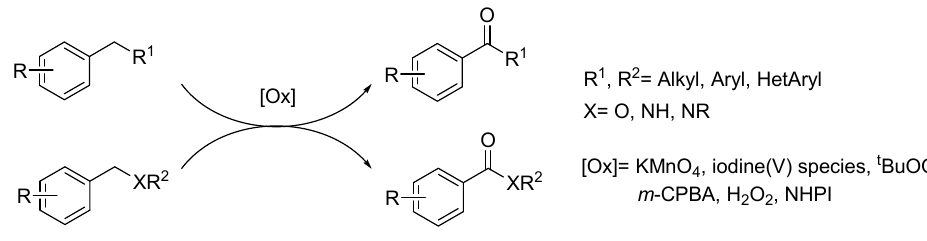
Figure 1. A selection of biologically relevant aromatic ketones and esters.